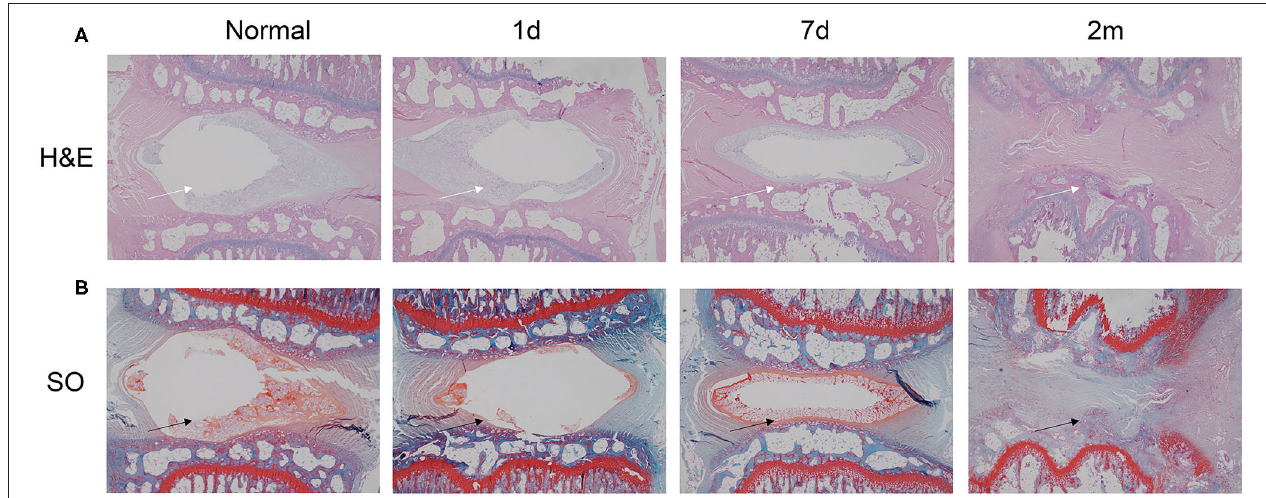
FIGURE 5 | HE and safranin-O staining of injured disks at various time points (1 day, 7 days, 1 month, and 2 months). (A) HE staining revealed that the needle puncture induced structural changes (white arrow) in the tissue of the herniated IVD. (B) Safranin-O staining demonstrated that after stab perturbation, the positively stained areas became much smaller (black arrow), indicating decreased proteoglycan content. HE, hematoxylin and